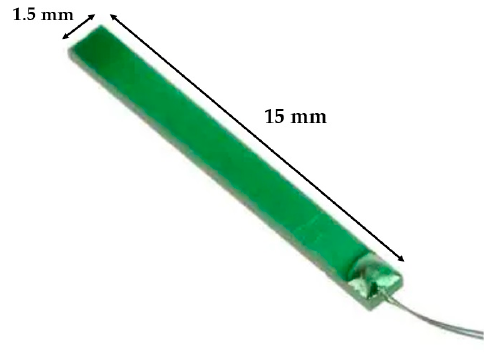
Table 5. Geometrical features of the cantilever beam.